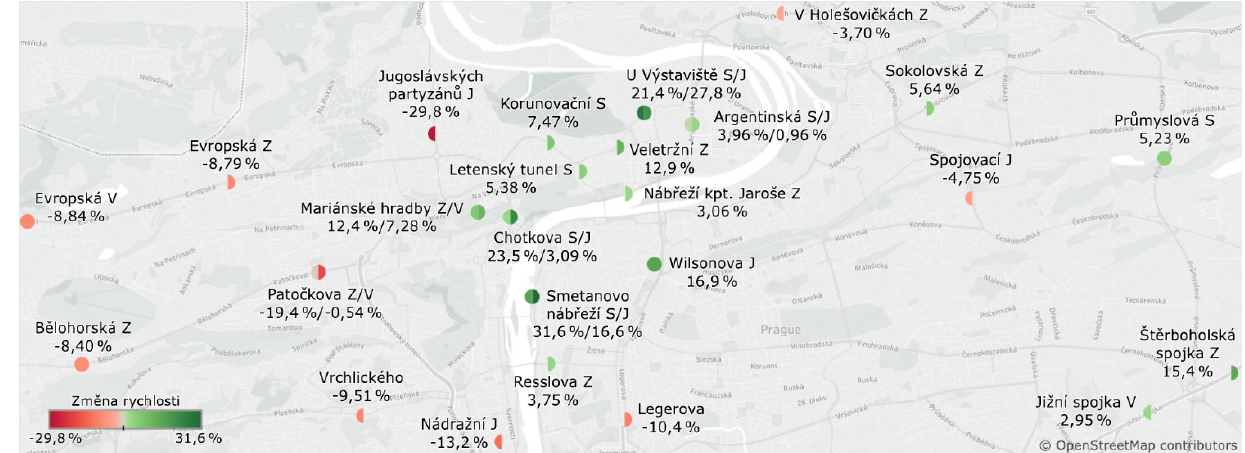
Figure 8. Changes in the average speed on selected sensors after opening the tunnel complex Blanka.